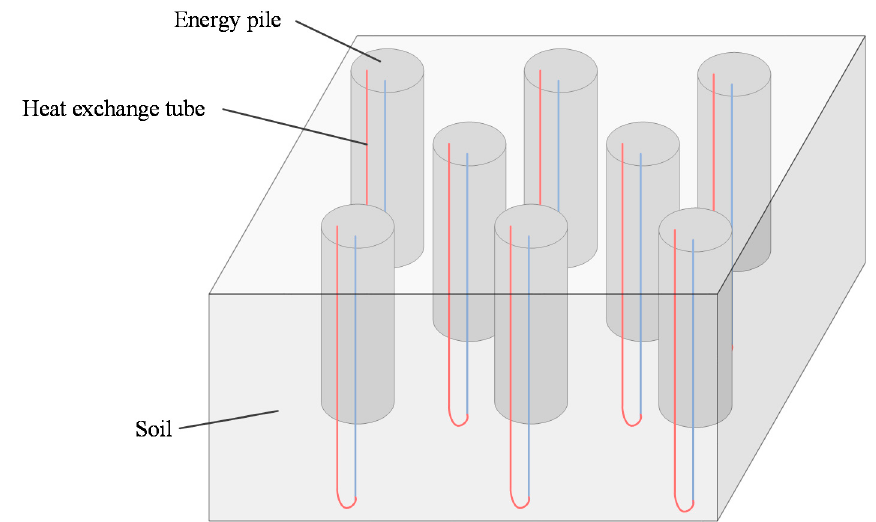
Figure 1. Schematics of the energy pile group embedded with a deeply penetrating U-shaped heat exchanger.